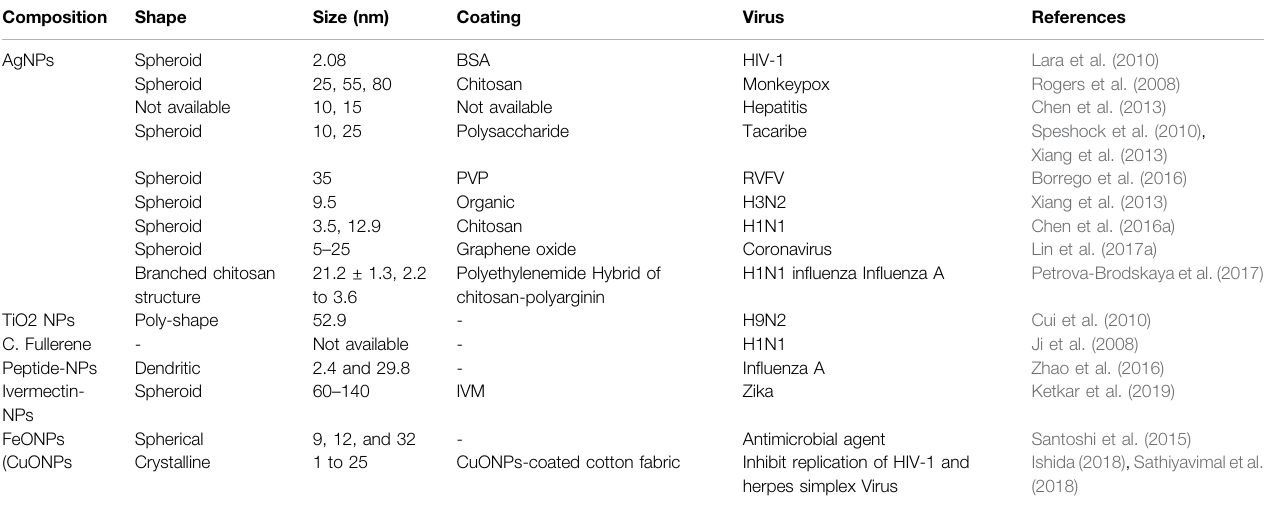
TABLE 1 | Illustration of antiviral nanoparticles that inactivate different types of Viruses.